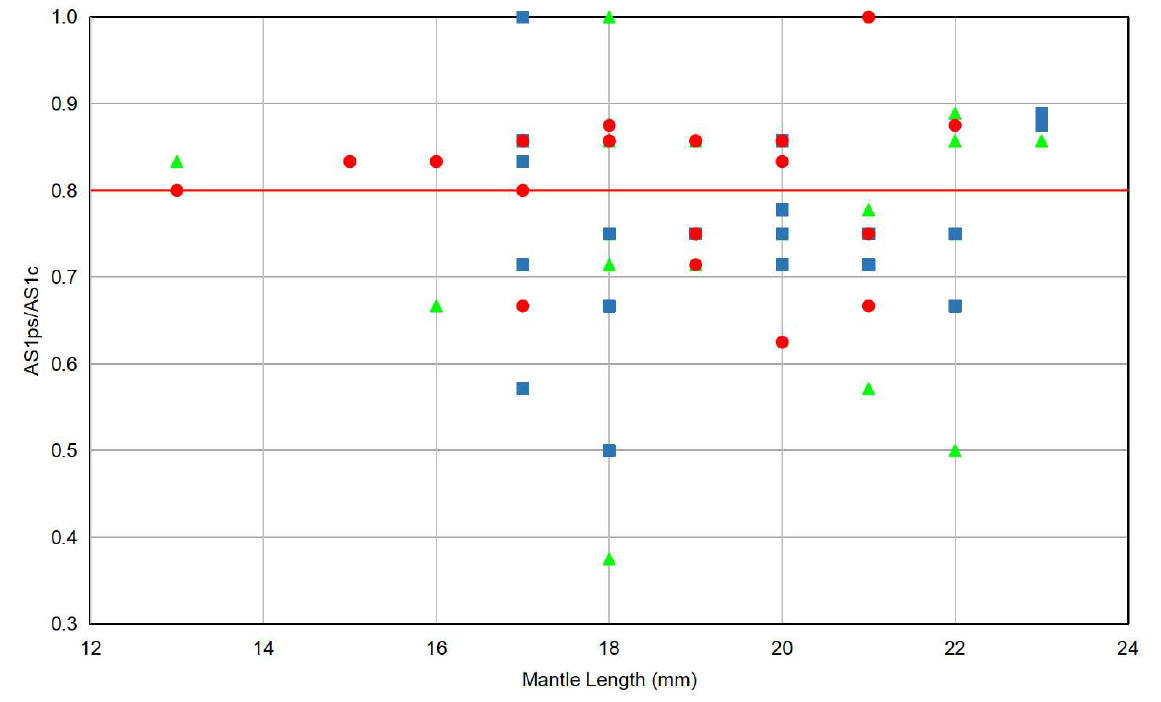
Figure 4. The diameter of the smallest proximal sucker as a proportion of the largest distal sucker of arm I p. (AS1ps/AS1c) in male Sepia typica plotted against dorsal mantle length (ML; mm). Symbols denote sampling area: Northwest ( green triangles ); Central ( blue squares ); and Eastern ( red dots ). The red line (proportion = 0.8) divides males with differentiated arm suckers (below the line) from those with undifferentiated arm suckers (above the line). Males with proportion = 0.8 are indeterminate.